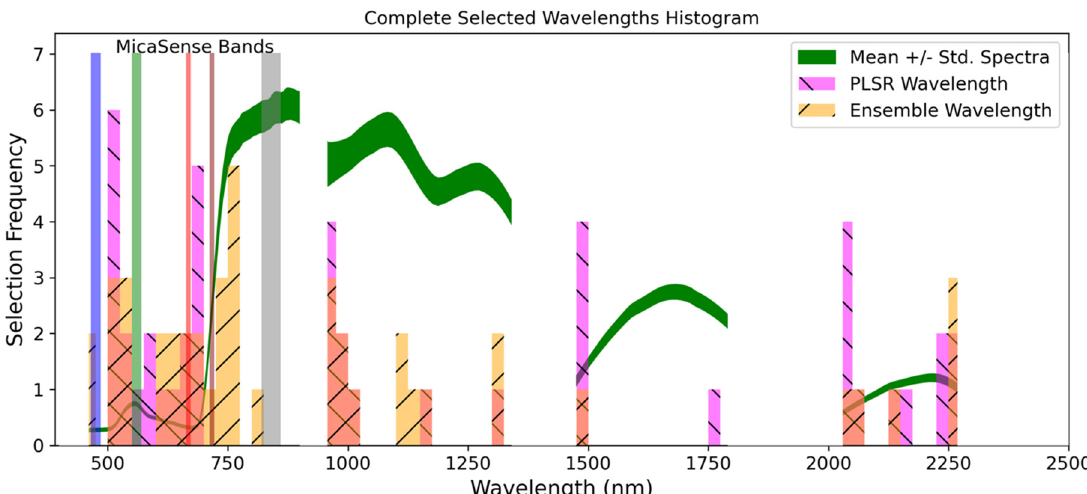
Figure 4. Frequency of the selected wavelengths from all the nutrient ensemble (orange hatch) and PLSR (magenta) models. An average grapevine spectrum is shown in green for interpretation of the relevant spectral regions. The location of the MicaSense blue, green, red, red-edge (brown), and near-infrared (gray) bands are noted in the VNIR for context.